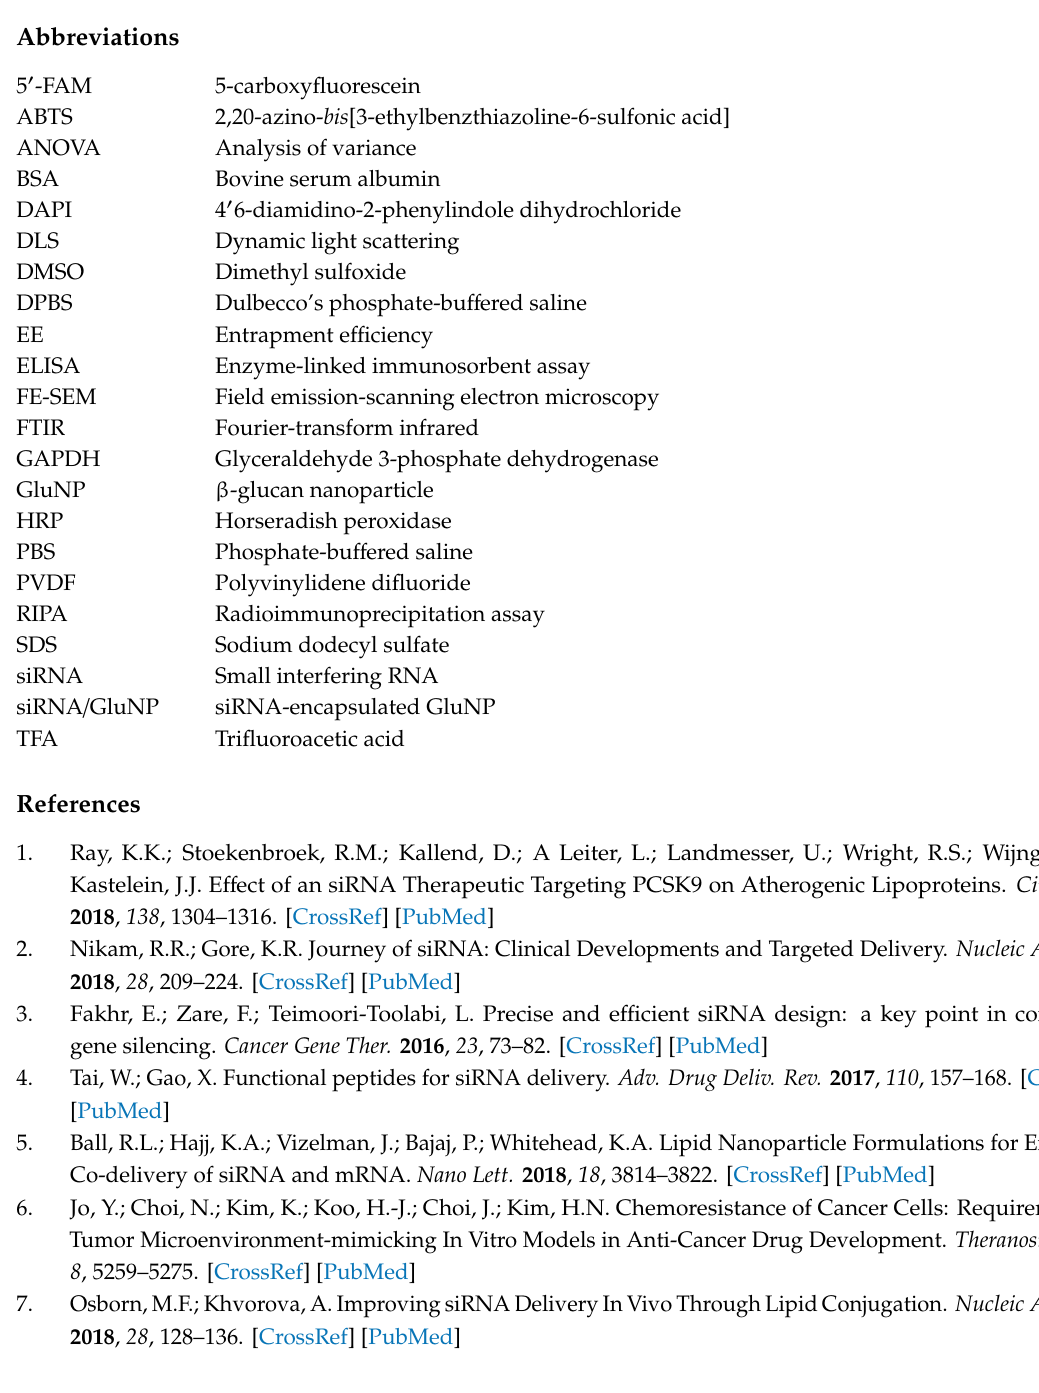
Figure S1: The bright field and fluorescence microscopy images of organotypic 3D skin cryosection. Supporting information containing the artificial skin penetration mechanism of GluNPs is